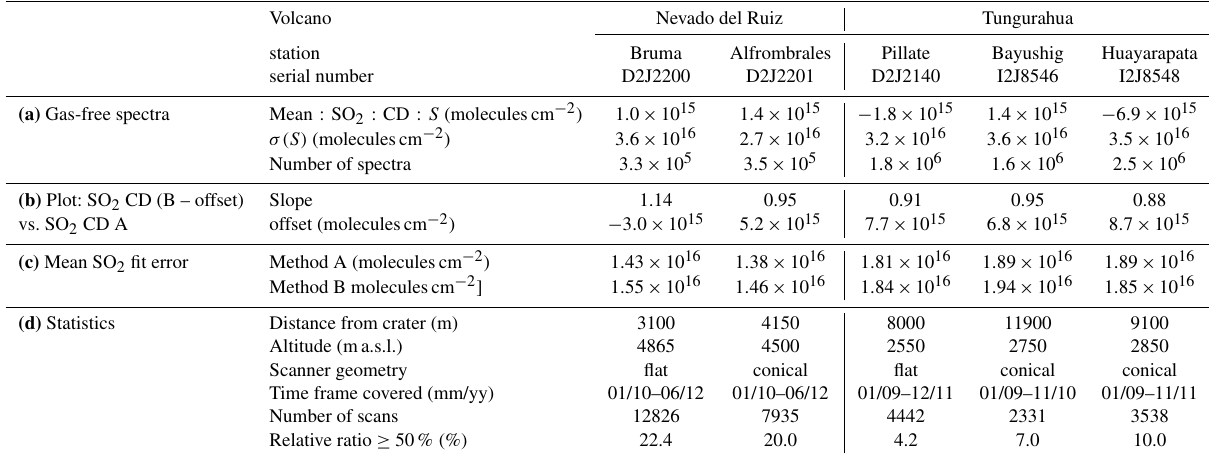
Table A1. Table showing data for the instruments at Nevado del Ruiz and Tungurahua. (a) Retrieved SO 2 CDs from Method B, their variation and how many gas-free spectra were taken into account for this statistic. (b) Results of a linear fit when plotting Method B – offset vs. Method A (see Fig. 6). (c) Comparison the SO 2 DOAS retrieval errors and (d) locations of the instrument and statistics on how frequently contaminated spectra